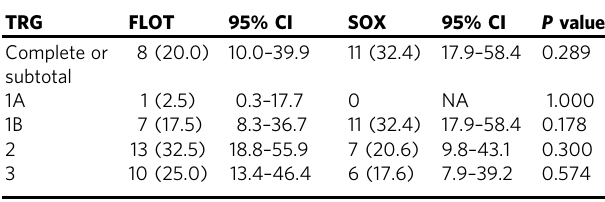
Table 5 Difference of histopathological tumor regression in intention-to-treat (ITT) population.